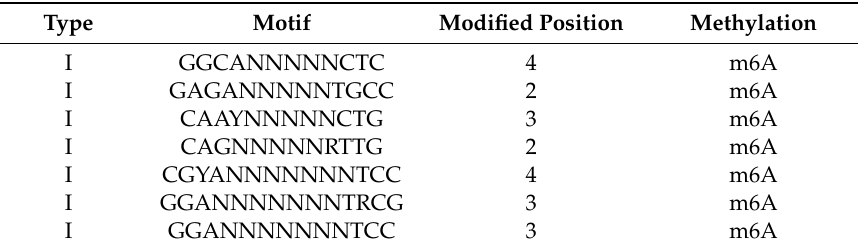
Table 2. Methylated motifs of B. bifidum CNCM